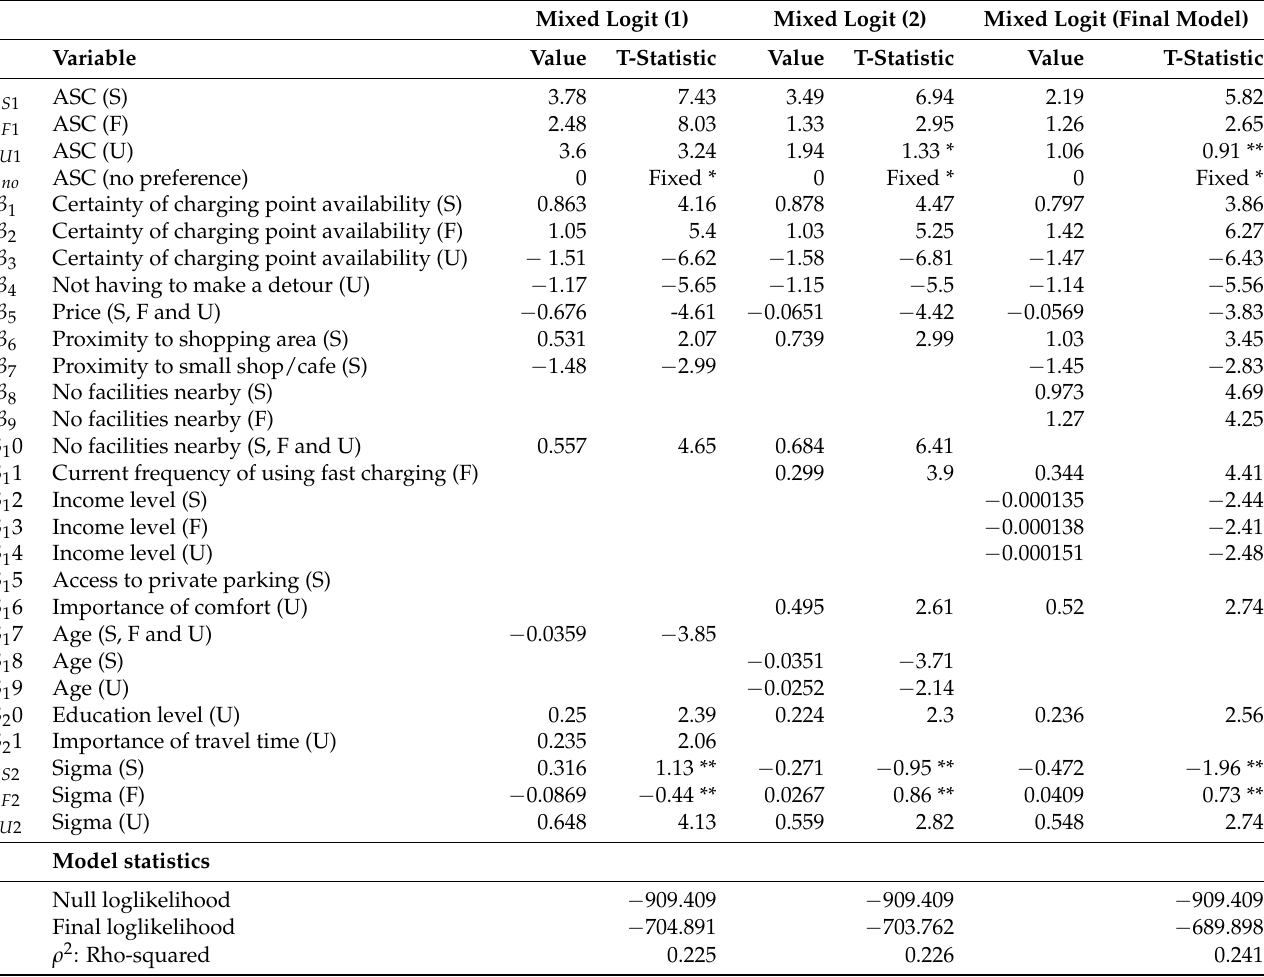
Table 4. Model estimation results. This table only displays the significant factors, which is why not every attribute is mentioned for slow, fast and ultrafast. (S) refers to slow, (F) to fast and (U) to